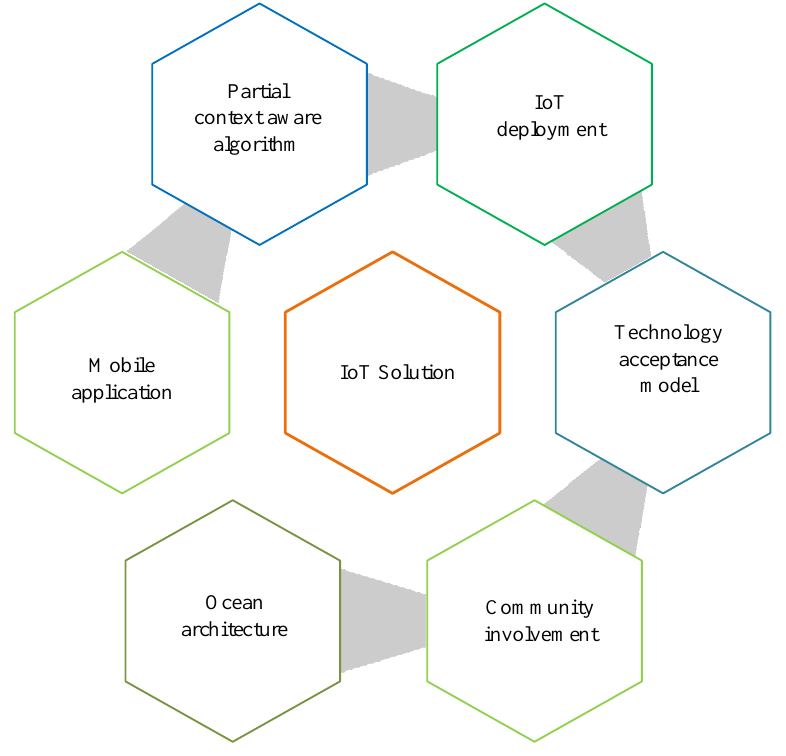
Figure 12. Components of the proposed IoT